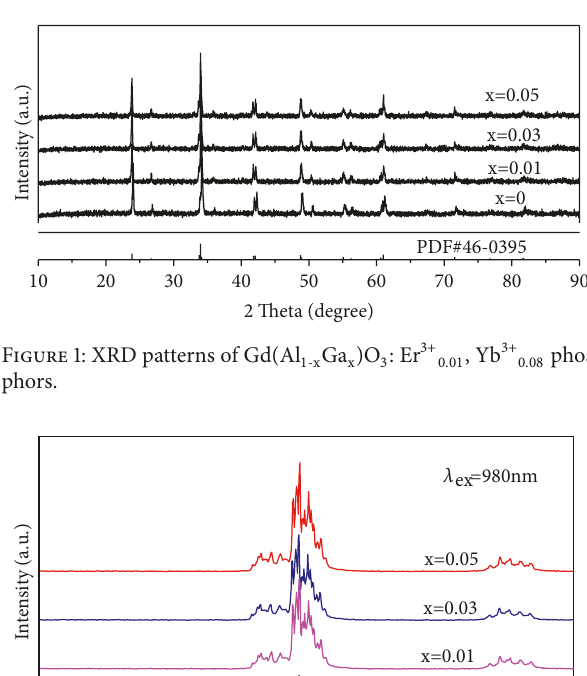
Ga x )O 3 : Er 3+ 0.01 , Yb 3+ 0.08 - x